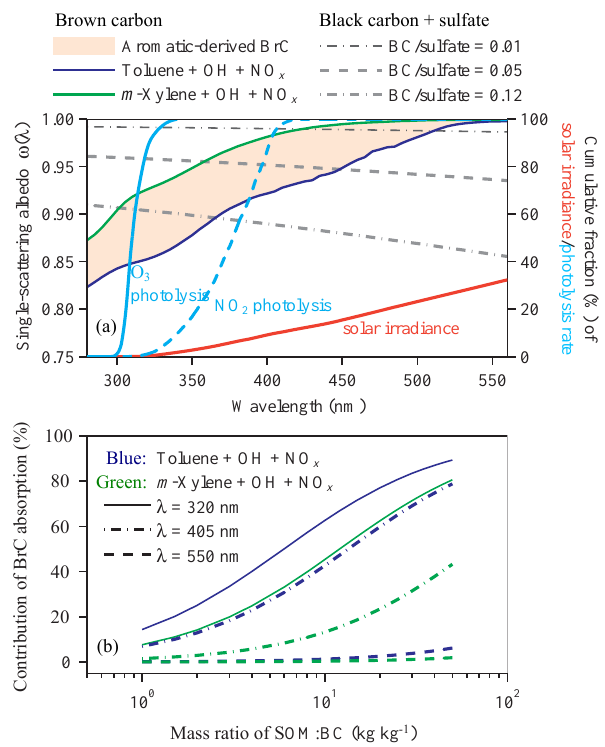
Figure 8. (a) Calculated single-scattering albedo of light absorb- ing particles for a scenario of an urban plume. Cumulative dis- tributions for solar irradiance (orange) and photolysis rate coef- ficients (light blue) are also shown. The k values of BrC were bounded by the cases for m -xylene + OH + NO x (HC 0 / NO 0 = 4 . 0ppbC ppbN − 1 ) and the toluene + OH + NO x (HC 0 / NO 0 = 3 . 5ppbC ppbN − 1 ) , as shown in Fig. 4. The cases for “BC + sulfate” represent a BC population externally mixed with an ammonium sulfate population at variable mixing ratios representative of typi- cal ambient values in a pollution plume (Ramana et al., 2010). Ta- ble 2 lists the physical parameters used for modeling the several different particle populations. The cumulative distributions were calculated for a standard solar spectrum of Air Mass 1.5 (http: //rredc.nrel.gov/solar/spectra/am1.5/). (b) Contribution of BrC ab- sorption to total absorption as a function of the mass ratio of organic matter to black carbon. The BrC cases were the same as those shown in (a) . External mixing of BrC and BC populations was assumed in the